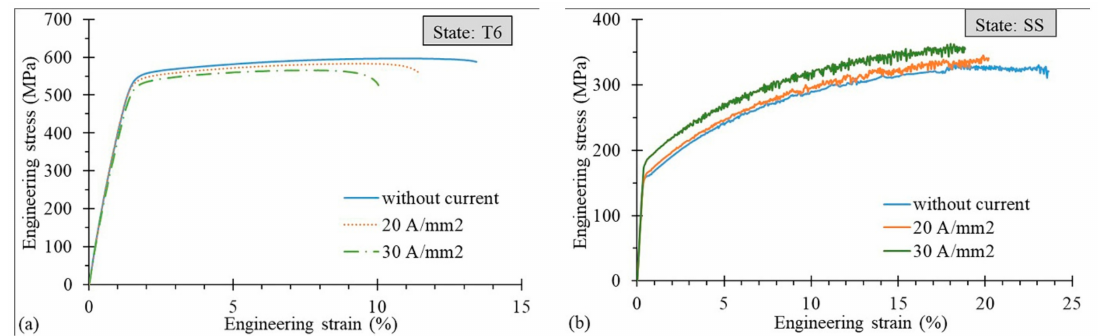
Figure 3. Engineering stress–strain curves for the AA7075-T6 ( a ) and SS ( b ) states at varying current density applications. Figure 4a,b plot the true strain at fracture ε f values as a function of the current density for the T6 and SS states, respectively, measured using the Aramis system. In the case of